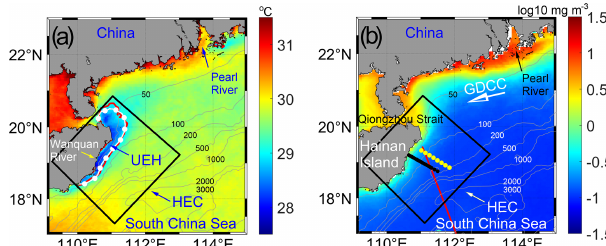
Figure 1. Study area (black square) and sampling sites. (a) Climato- logical (June–August) sea surface temperature (SST) and (b) Chl a concentration during 2003–2020. In (a) , the dotted white curve is the SST front for June–August; the red curve is the 29 ◦ isotherm. In (b) , the dots are the observation sites for the cruise during 14–15 July 2021 (black) and 2–3 October 2019 (yellow), and the red curve is the altimeter satellite ground track (Track 114). The unit of the numbers on the isobaths is